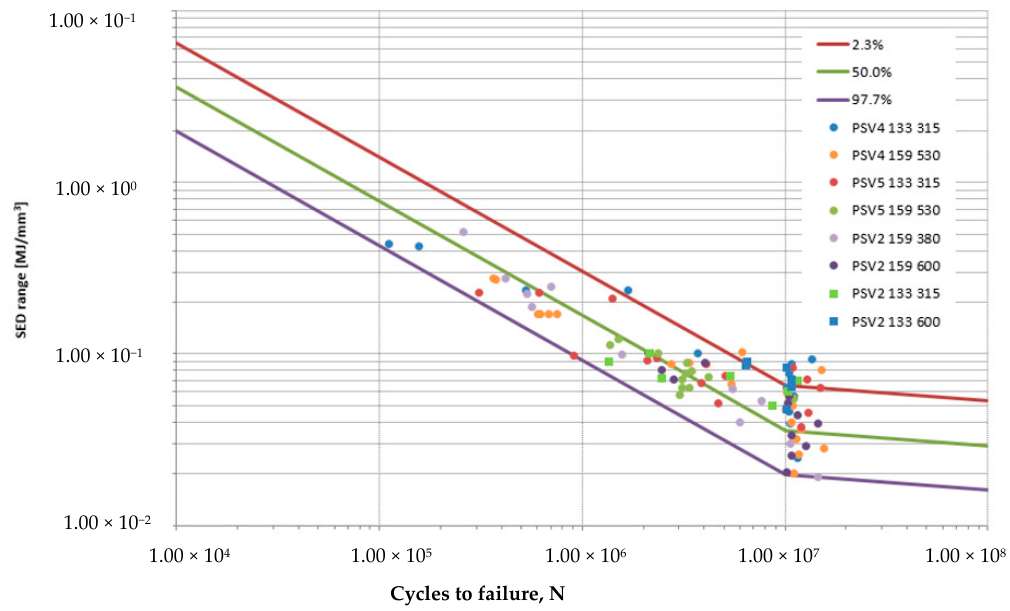
Figure 6. Synthesis of fatigue data for different roller geometries in terms of local SED and a comparison with the scatter band shown in Figure 1.